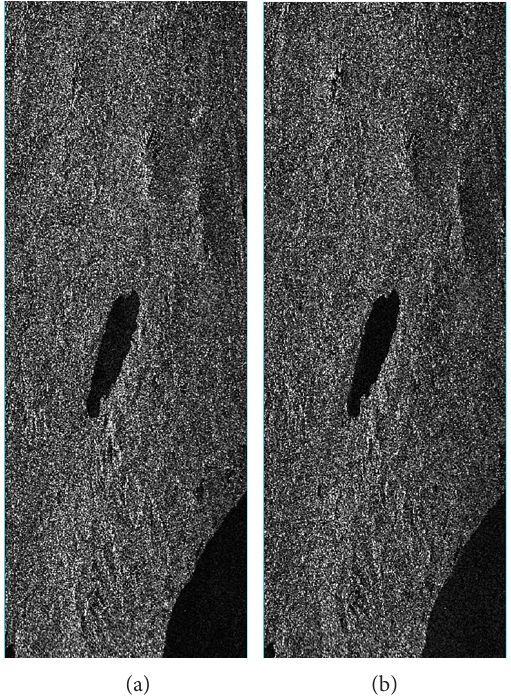
Figure 5. a – master image of ALOS PALSAR;